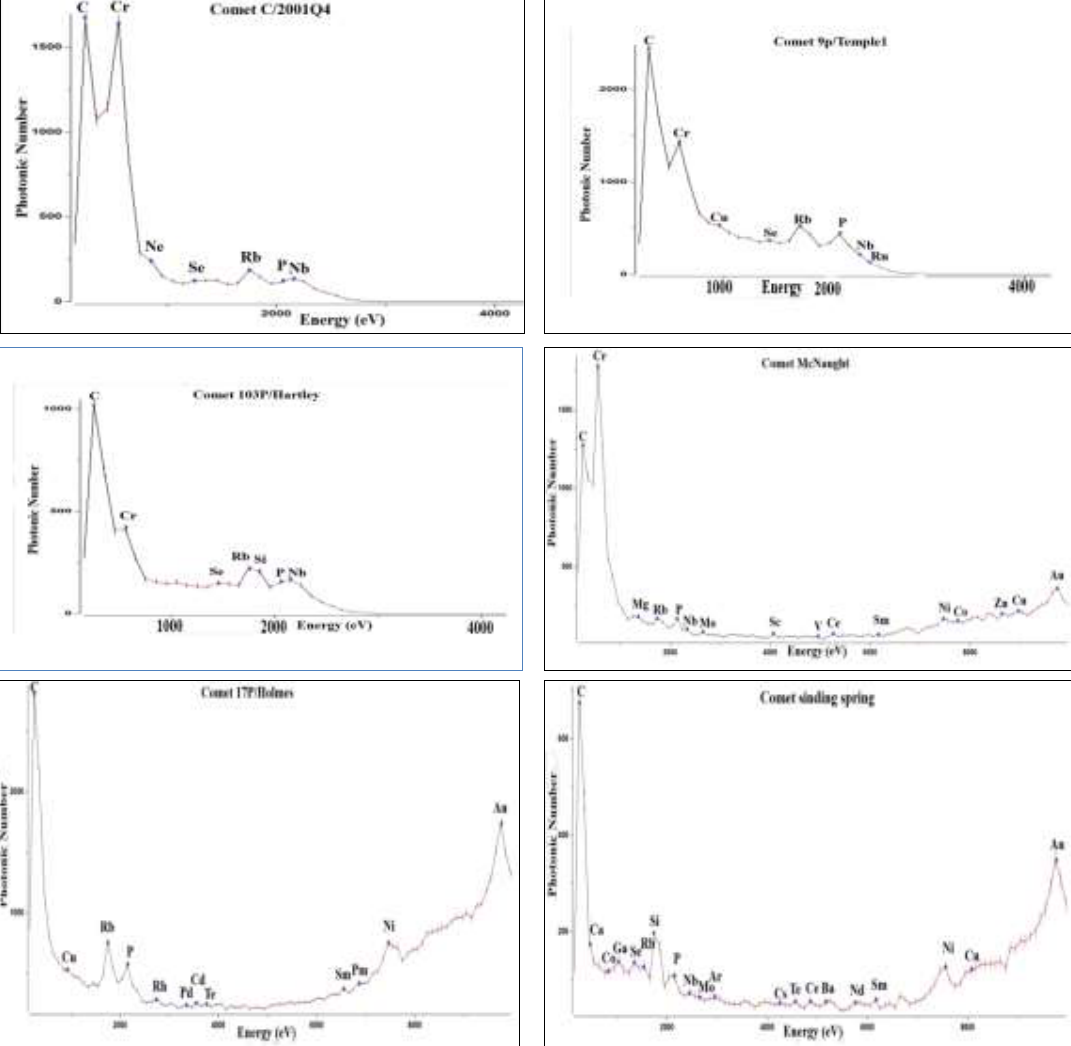
Figure 1: Photons number as a function of